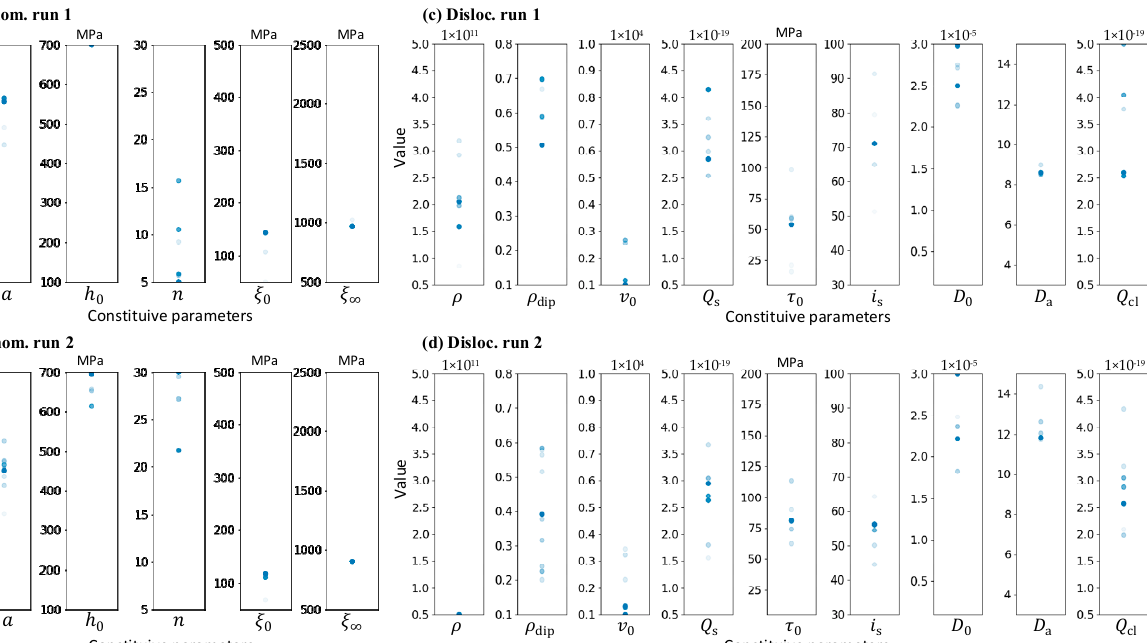
rameter 𝜉 (cid:2868) and 𝜉 (cid:2998) of the phenomenological CP model is consistent in run 1 and run 2, while 𝑛 shows a wide range of distribution in these solutions and 𝑎, ℎ (cid:2868) converges to a different point, as shown in Figure 14a,b. For the dislocation-density-based CP model This is caused by two reasons. One is that some parameters have little impact on the me- chanical response, and the other is the coupling effects between different CP parameters. This parameter uncertainty is severer in the complex CP model with many parameters to be determined. These effects will be further discussed in Section 4.2.3.